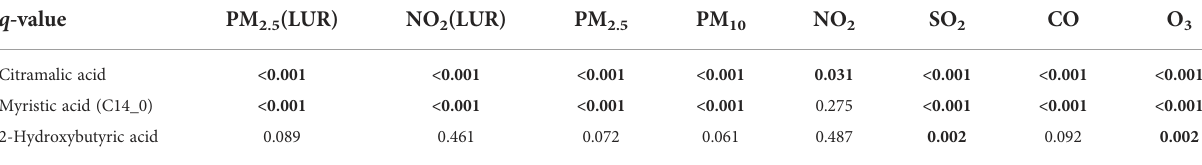
TABLE 5 q -values for metabolites with signi fi cant association with one or more pollutants. q